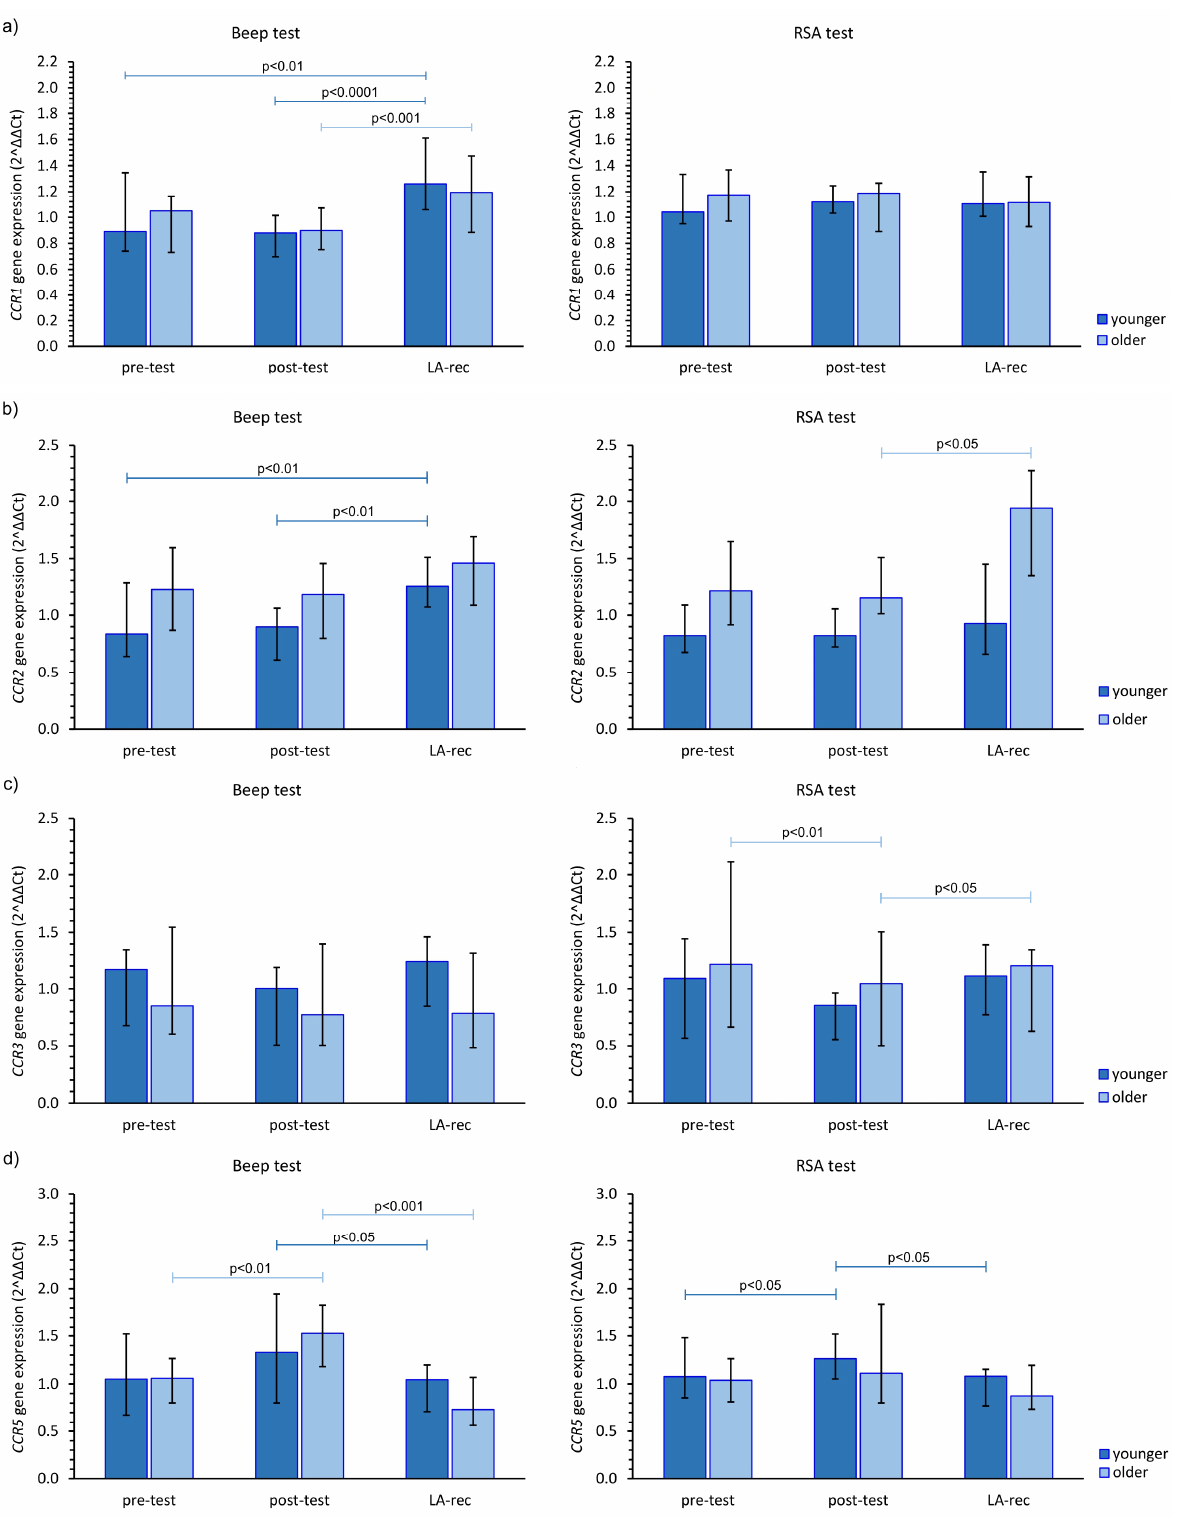
Figure 2. The impact of aerobic (Beep test) and anaerobic (RSA test) effort on the relative expression of studied genes encoding ( a ) CCR1 , ( b ) CCR2 , ( c ) CCR3 , ( d ) CCR5 . The figures present median (interquartile range) values. Significance levels of differences observed between analyzed time points (pre-test vs. post-test vs. LA-rec) were assessed using Friedman’s analysis of variance for repeated measures followed by post hoc Dunn’s test with Bonferroni correction.